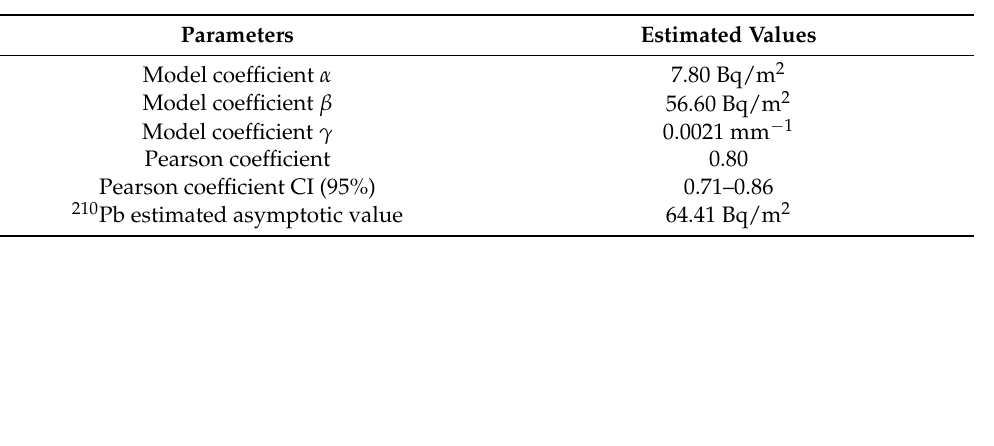
Table 1. Estimated coefficients and statistical parameters of the